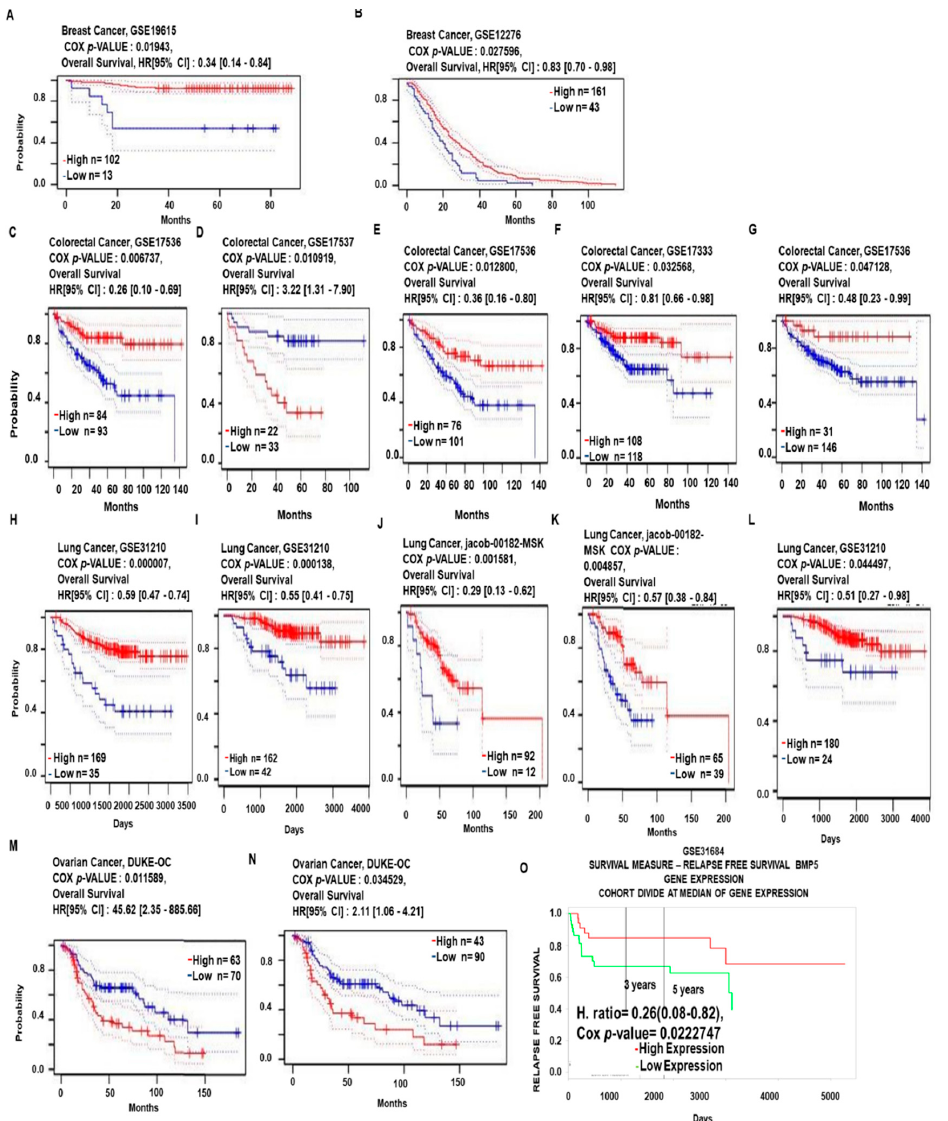
Figure 3. Relationship between BMP5 expression and prognosis in various cancer patients. The survival curve comparing patients with high (red) and low (blue) expression in breast cancer ( A , B ), colorectal cancer ( C – G ), lung cancer ( H – L ), ovarian cancer ( M , N ) were retrieved from the PrognoScan Database. ( O ) Comparison of high (red) and low (green) BMP5 expression in bladder cancer patients plotted from the PROGgene V2 database. Survival curve analysis was conducted using a threshold Cox p -value < 0.05. The dotted lines represent maximum and minimum values of the survival average.